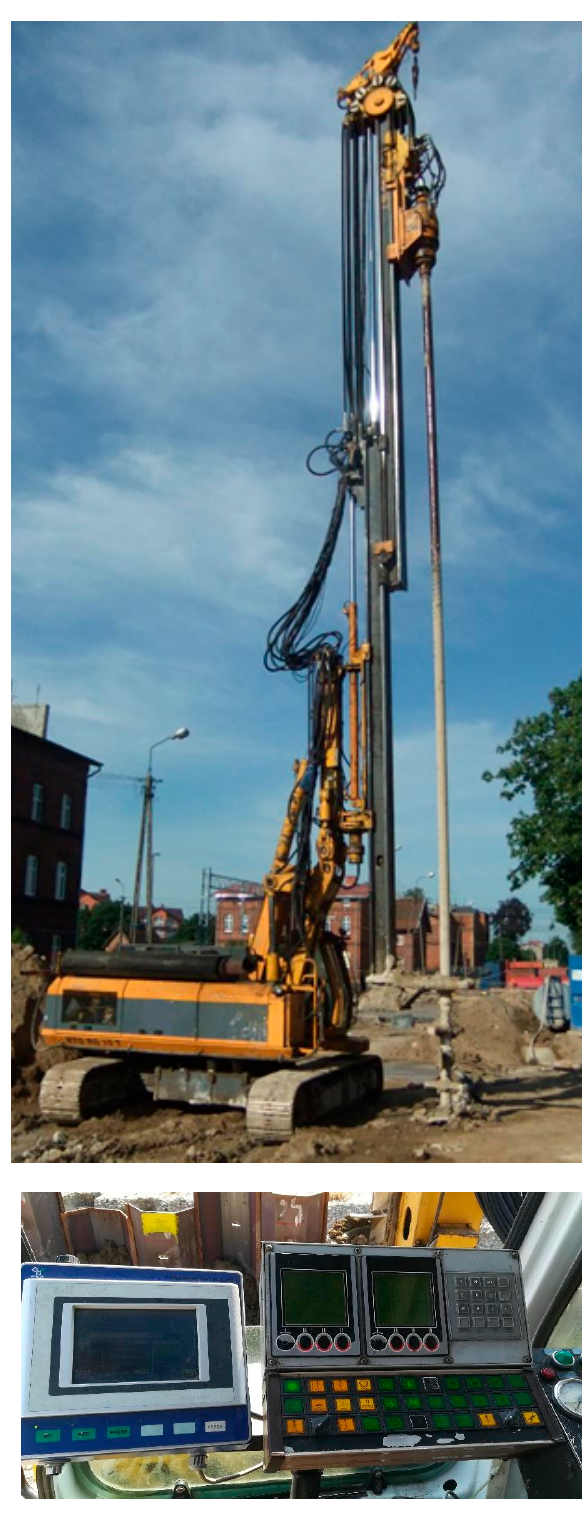
Figure 2. The machine used for performing Deep Soil Mixing (DSM) columns including the production parameter logging system.